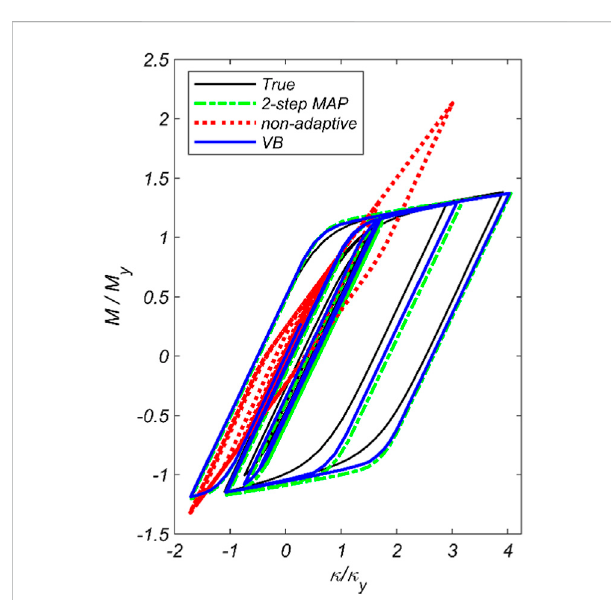
FIGURE 10 Moment – curvature responses at the base of the inner column obtained by the true model and the updated one using the three methods: the proposed VB method, the two-step marginal MAP estimation method, and the non-adaptive Bayesian